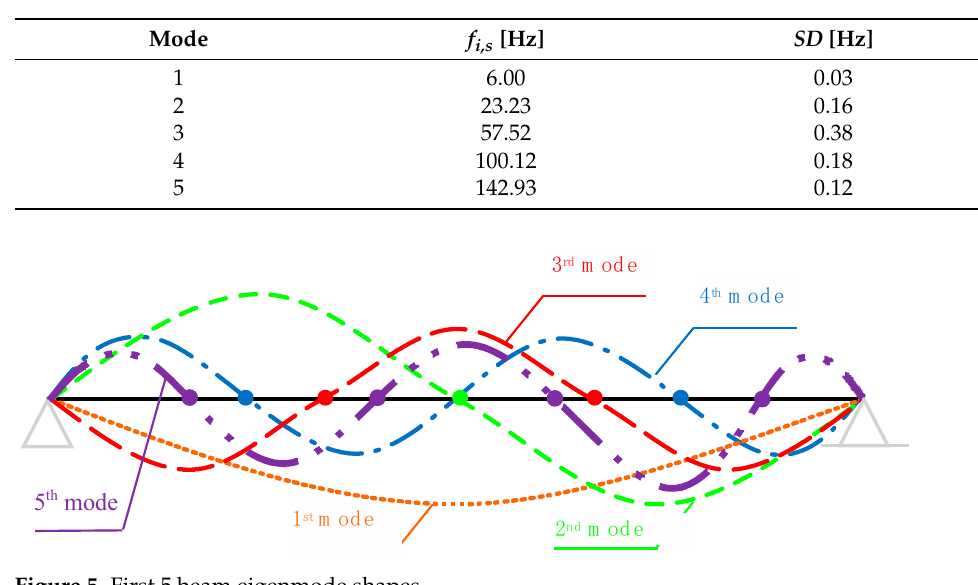
Figure 5. First 5 beam eigenmode shapes.